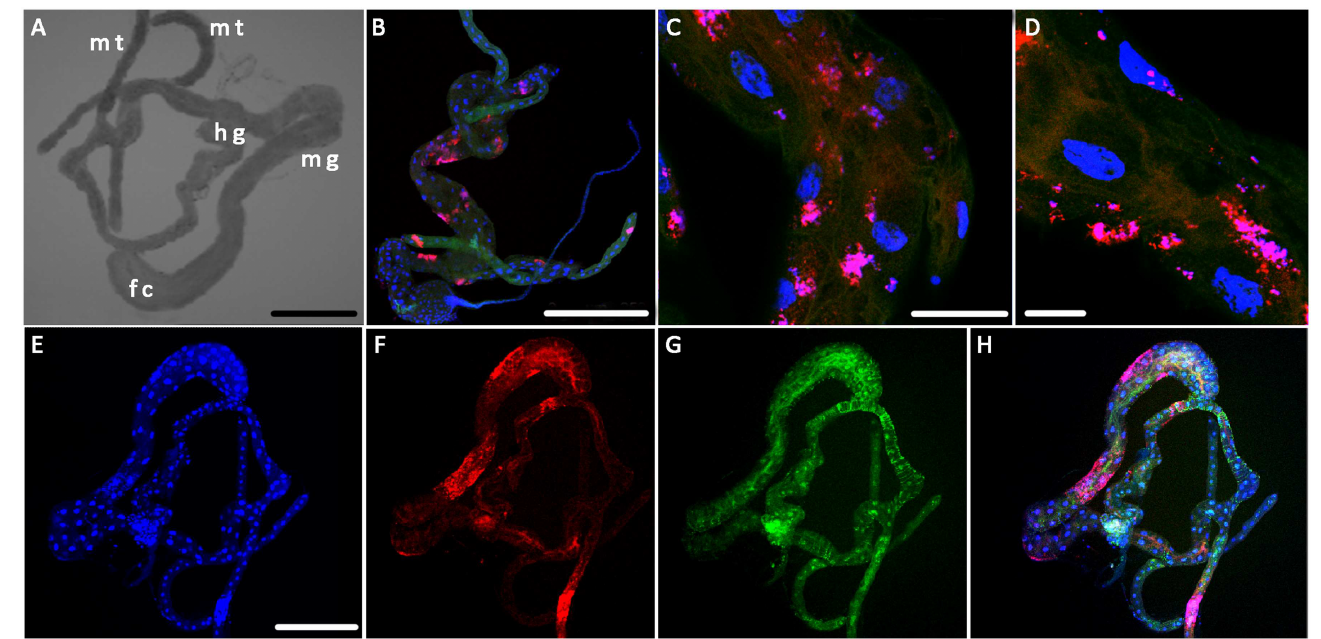
Fig 4. Fluorescent in situ hybridization to visualize microbial interactions in ACP guts. Dissectedguts were reacted with probes specific to CLas (green) and Wolbachia (red) and imaged using confocalmicroscopy. Nuclei are stained using DAPI and visualizedin blue. (A) Light imaging allowedfor identification of regionsof the gut, scale bar = 250 μ m,mt = Malpighiantubule, hg = hindgut, mg—midgut, fc = filter chamber. (B) Confocal micrographsof CLas- guts show no CLas signaland patchy distributionof Wolbachia (B, C, D), scale bars = 250 μ m,50 μ m and 25 μ m,respectively. (E-H) Confocalmicroscopyof CLas+ guts shows a wider distributionof CLas in the gut and a patchy distributionof Wolbachia in the gut, with Wolbachia signal concentrated in the filter chamber, midgut, and Malpighian tubules, scale bar = 250 μ m.